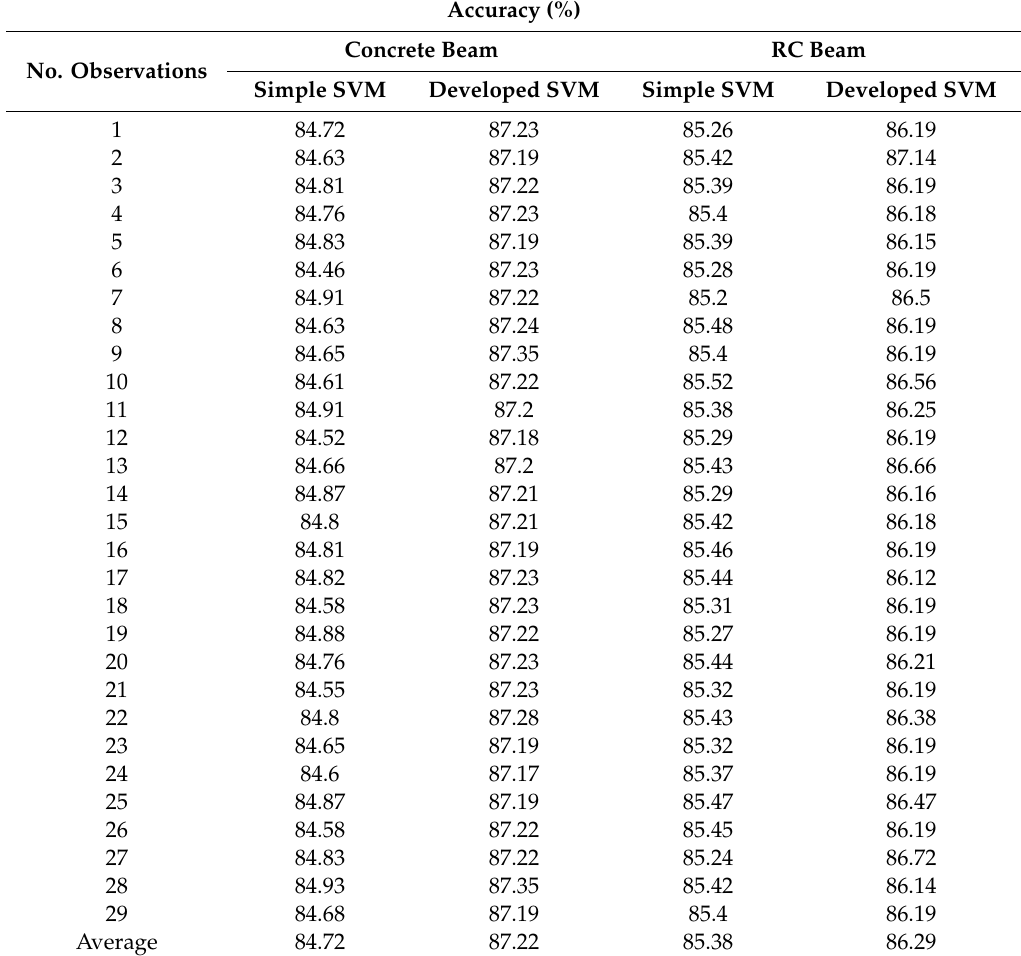
Table 2. Comparison of accuracy between the traditional and the developed Support Vector Machine (SVM).